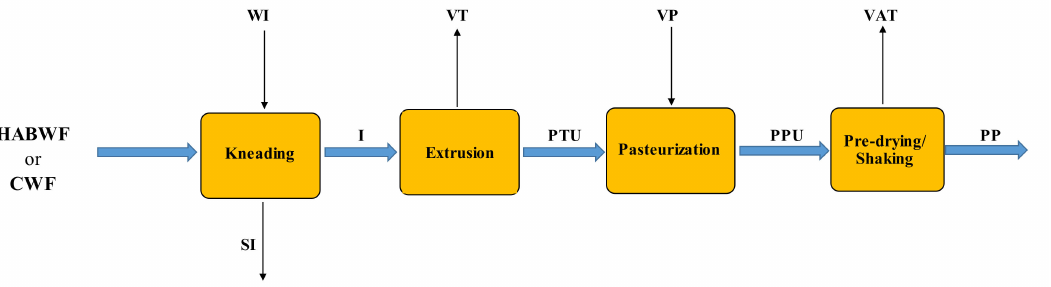
Figure 3. Flowchart of the fresh pasta making, pasteurization, and pre-drying processes using HABW flour or type 00 common wheat flour (CWF). All symbols were listed in the Nomenclature